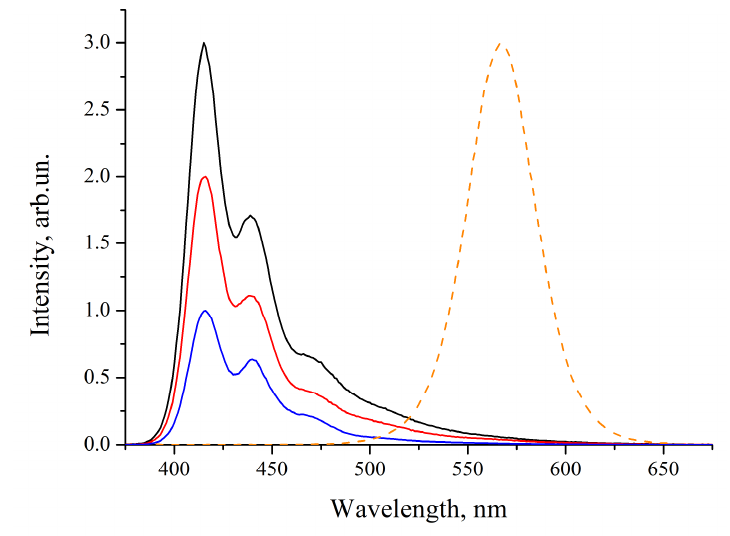
Figure 1. Luminescence spectra of polymer solutions and quantum dots (QDs). Polymer p99 (black), polymer p79 (red), and polymer p133 (blue) in toluene; luminescence spectrum of CdSe / MS QDs in toluene (dashed orange line).